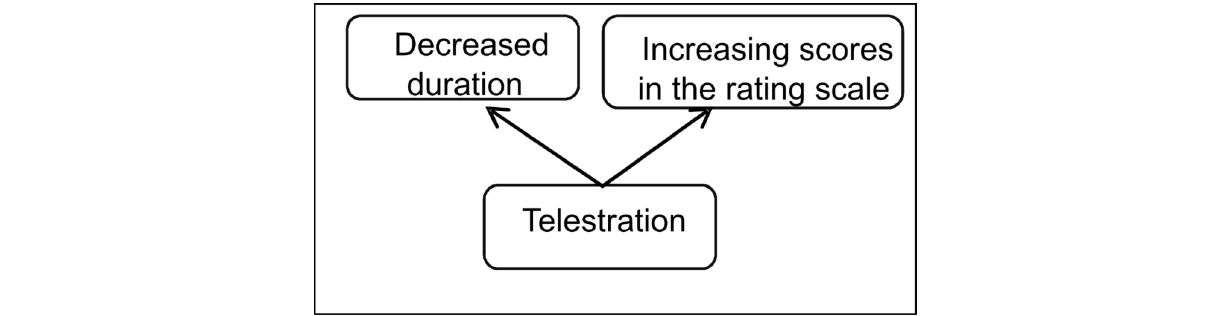
Figure 4. Educational outcomes of telestration.